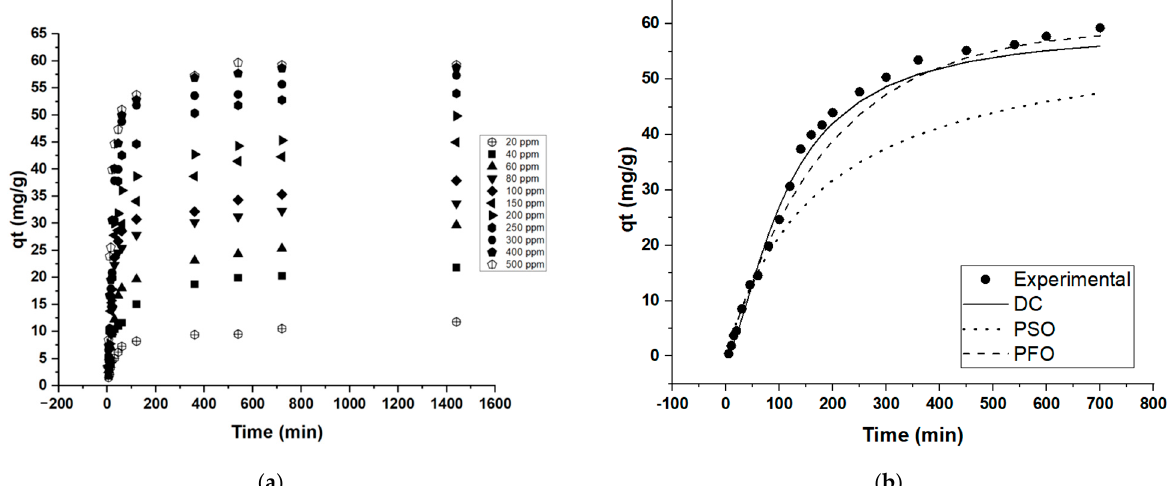
Figure 6. MB adsorption capacity (qt) Vs. time; ( a ) contact time trend, ( b ) best-fit kinetic models.